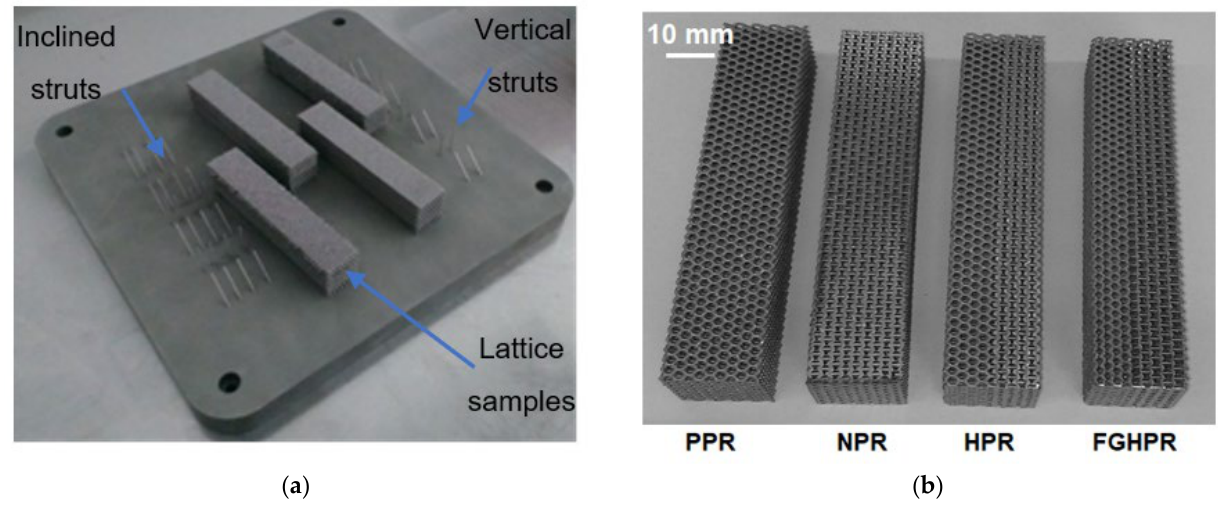
Figure 5. Photographs showing: ( a ) the struts and lattice samples on the LPBF building platform; ( b ) the as-built four lattice samples.